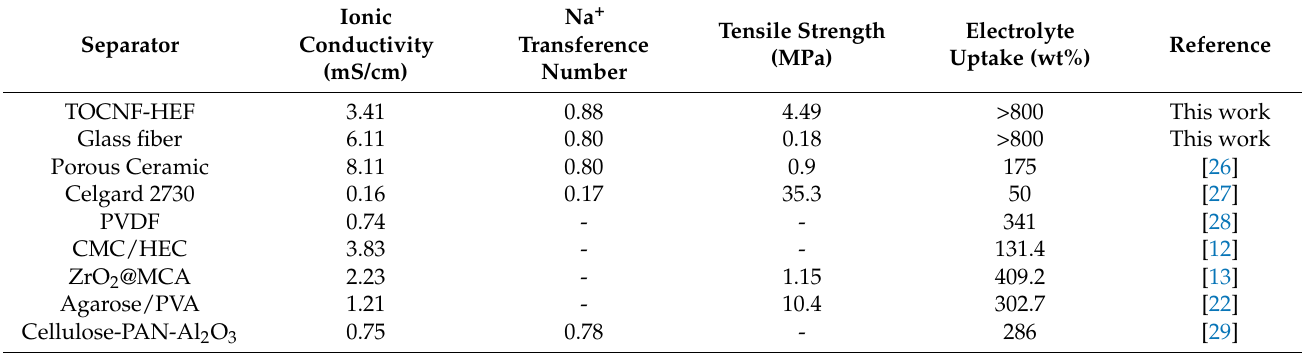
Table 2. Comparison with other separators reported in literatures for SIB.